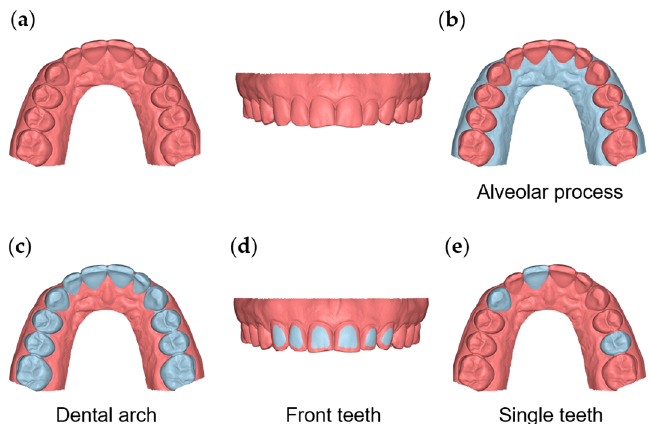
Figure 1. The 3D model and reference areas used in the study. ( a ) The whole 3D model cropped within 7 mm apical to the gingival margin area and distal to the first molar. ( b ) The area of the buccal and palatal gingival and oral mucosa from the gingival margins to 7 mm apically. ( c ) The dental arch area, including all maxillary teeth from first molar to first molar. ( d ) The area of the buccal surfaces of the maxillary anterior teeth. ( e ) Clinical crowns of teeth #11, #13, and